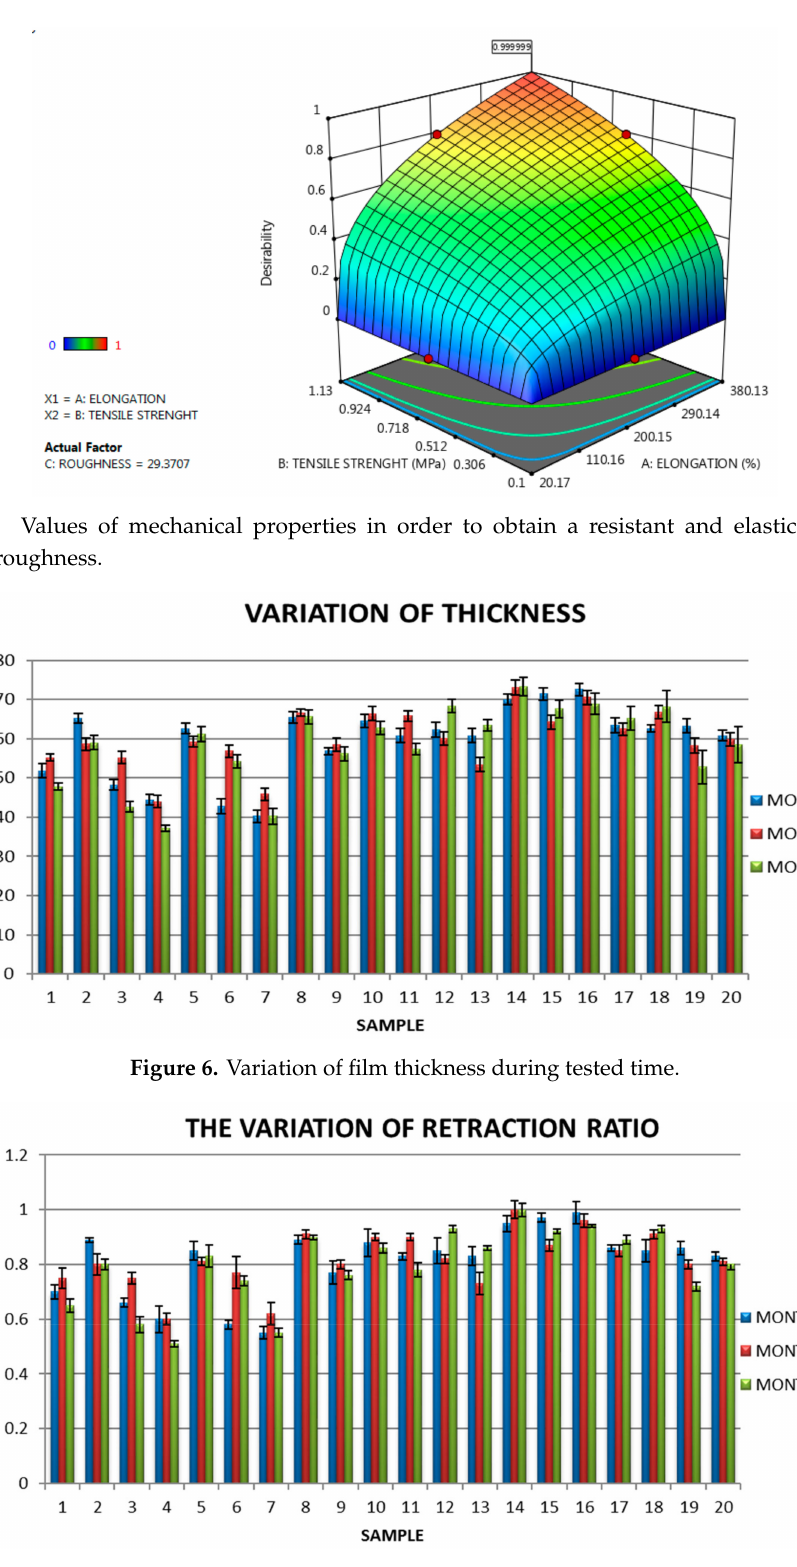
Figure 7. Variation of the retraction ratio during the three months of